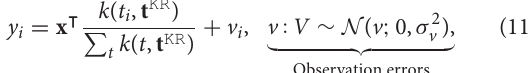
With the dynamic regression component, the hidden state variable x DR acts as a regression coefficient that is modulating t